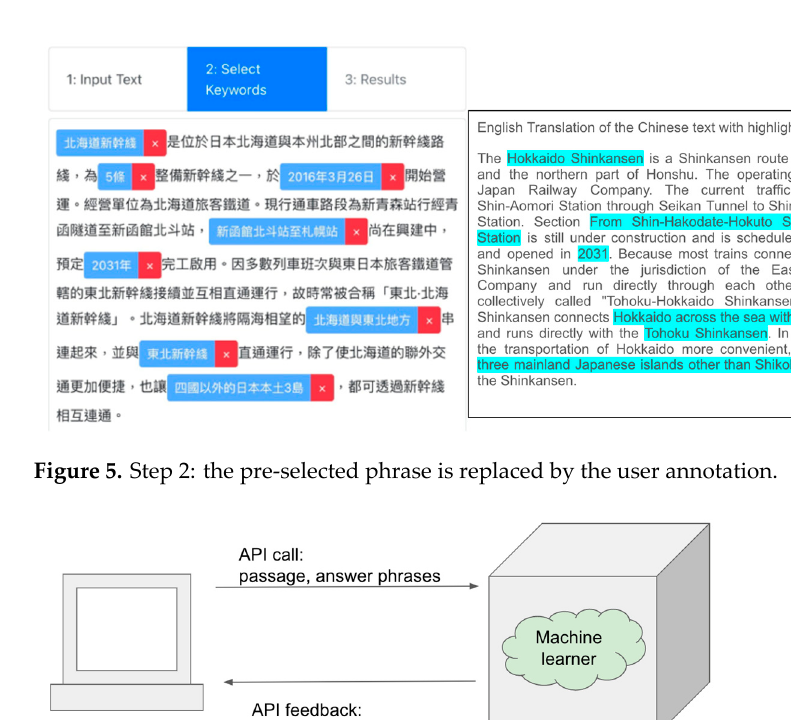
Figure 4. Step 2: the user can edit the annotation by removing or adding new phrases.